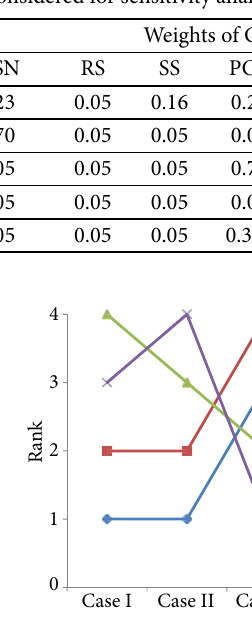
Fig. 3. The results of sensitivity